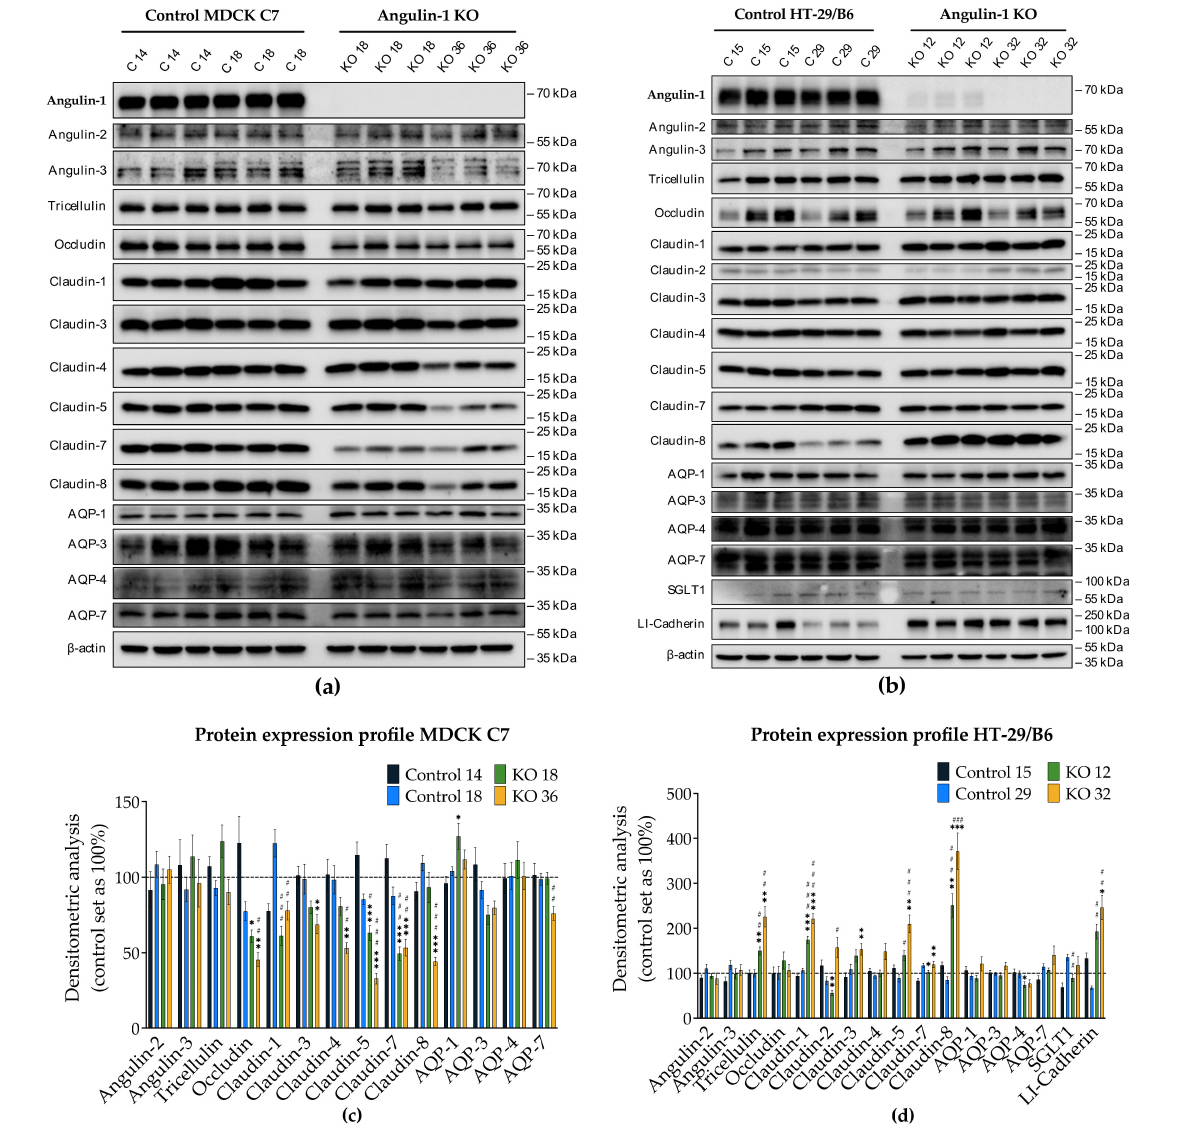
Figure 2. Angulin, tricellulin, occludin, claudin, and aquaporin (AQP) expression in control and angulin-1 knockout cells. Representative Western blots of angulin-1 knockout in ( a ) MDCK C7 and ( b ) HT-29/B6 cells. Densitometric analysis of protein expression levels in ( c ) MDCK C7 and ( d ) HT-29/B6 cells after angulin-1 knockout in comparison to the corresponding vector-transfected controls ( n = 9, N = 3). β -Actin was used as an internal control for normalization to protein content. Statistical analysis was performed using one-way ANOVA test to compare between the four clones in both cell lines (MDCK C7: * p ≤ 0.05, ** p ≤ 0.01, *** p ≤ 0.001 with regard to control 14 and # p ≤ 0.05, ## p ≤ 0.01, ### p ≤ 0.001 with regard to control 18 and HT-29/B6: * p ≤ 0.05, ** p ≤ 0.01, *** p ≤ 0.001 with regard to control 15 and # p ≤ 0.05, ## p ≤ 0.01, ### p ≤ 0.001 with regard to control